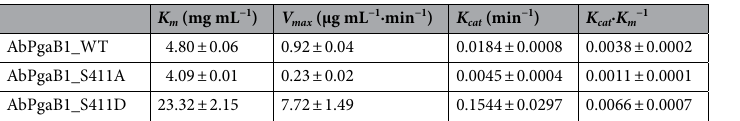
Table 1. Comparison of the kinetic parameters between AbPgaB1 and its Ser411-mediated